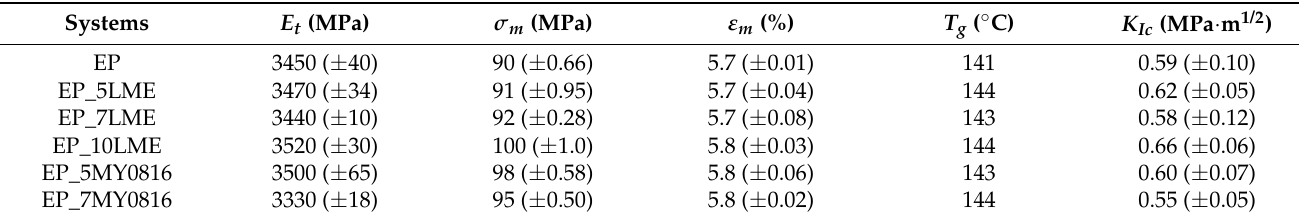
Table 4. Mechanical, thermal, and fracture properties of the reference system and modified systems.